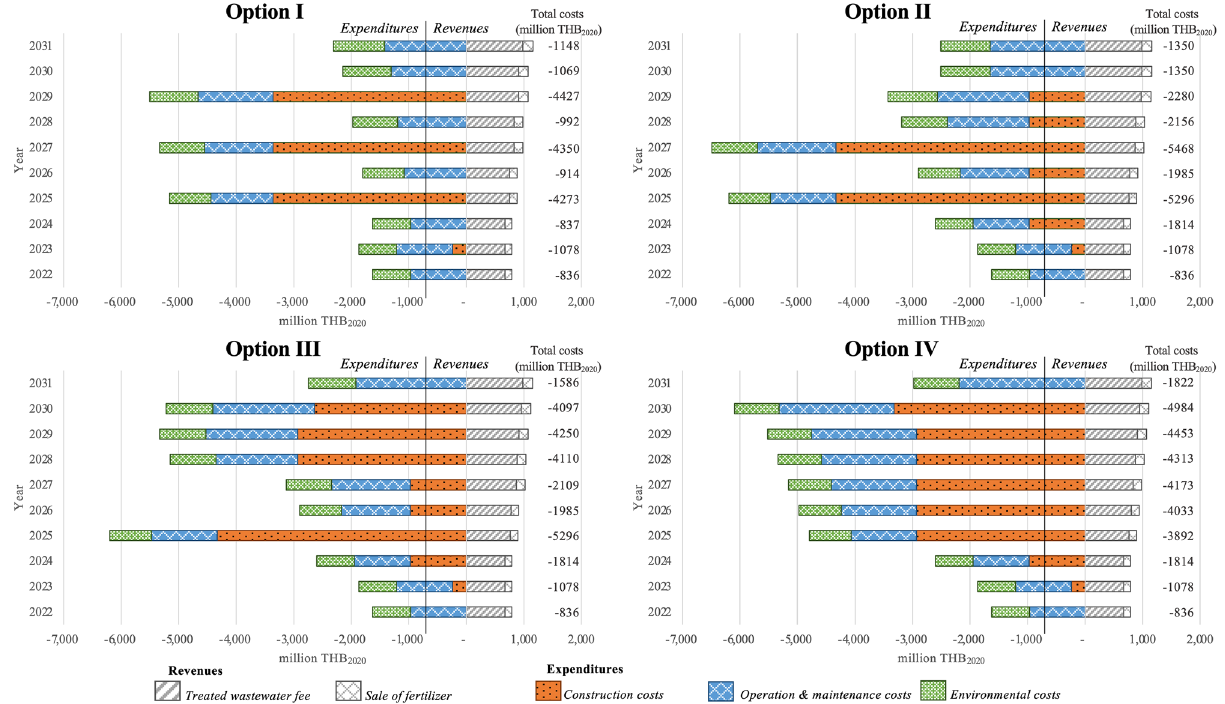
Figure 6. LCCA of the four WWTP construction options in million Thai baht 2020